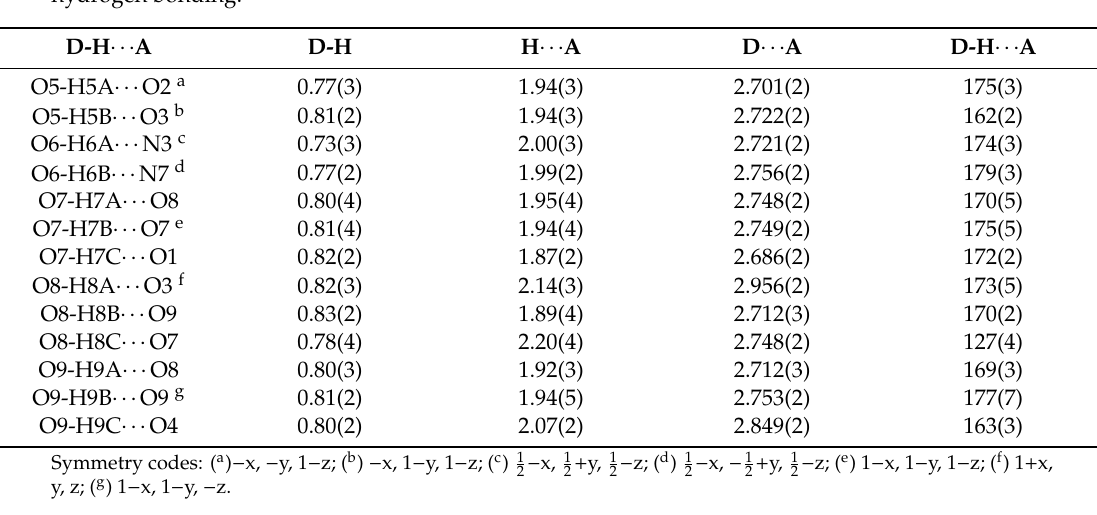
Table 2. Hydrogen bond geometry in 1 ( ◦ , Å). H7A, H8A, and H9A atoms are disordered over two sites, their secondary positions are labeled H7B, H8B, and H9B, respectively. All of those sites participate in hydrogen bonding.